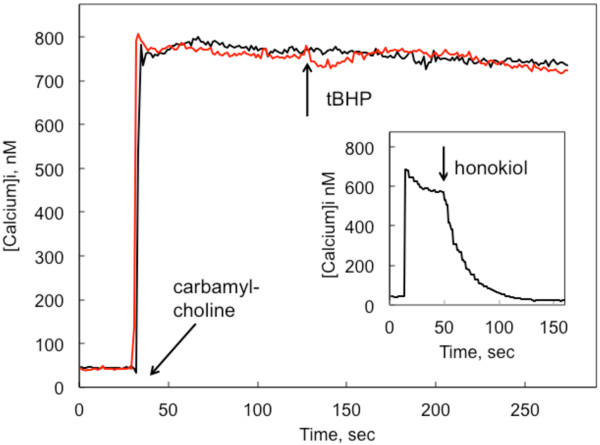
Acute effect of tBHP on SOCE. Fura-2-loaded CHO-M3 cells were stimulated with 10 μM carbamylcholine at the point indicated by the labeled arrow. tBHP (20 mM) was added at the 120 sec time point, as indicated by the arrow labeled “tBHP”. Under these assay conditions, the addition of direct inhibitors of SOCE channels, such as honokiol [21], 2-aminoethoxydiphenylborane, 1-(5-chloronaphthalenesulfonyl)homo piperazine hydrochloride (ML 9), and ZnO nanoparticles, cause an immediate reduction of SOCE; data from a typical experiment with 30 μM honokiol are presented in the insert for comparison purposes.